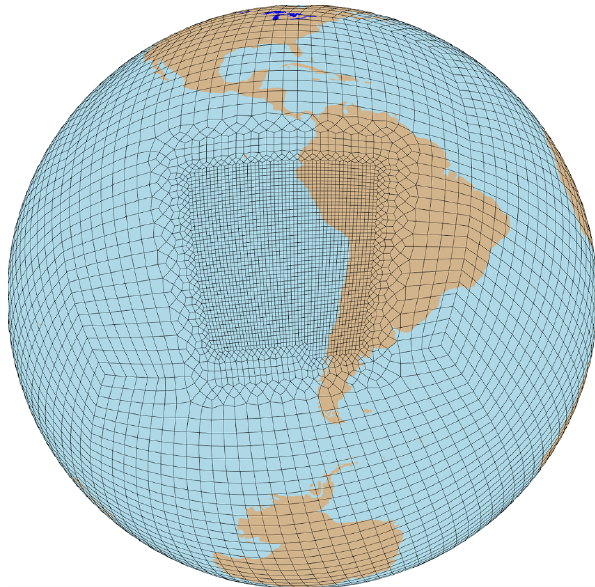
Figure 1. Depiction of the grid mesh used for the SEP-RRM-CNTL and SEP-RRM-FIVE simulations in this paper, with the ne120 res- olution used within the refined region and the ne30 resolution used outside of this region. Note that each element shown contains addi- tional 3 × 3 collocation